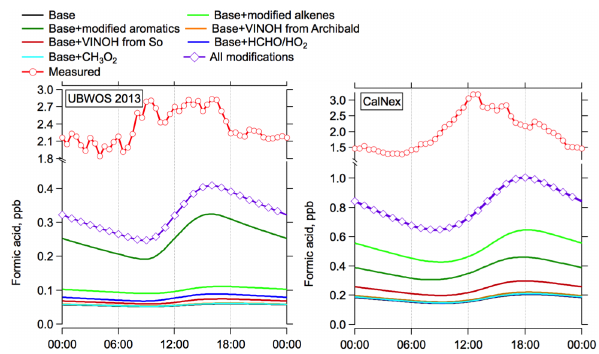
Figure 4. Comparison of measured and modeled diurnal profiles of formic acid for UBWOS 2013 (left) and CalNex (right). A zoom of the figure is shown in Fig. S3. Note that the scales of the y axis are